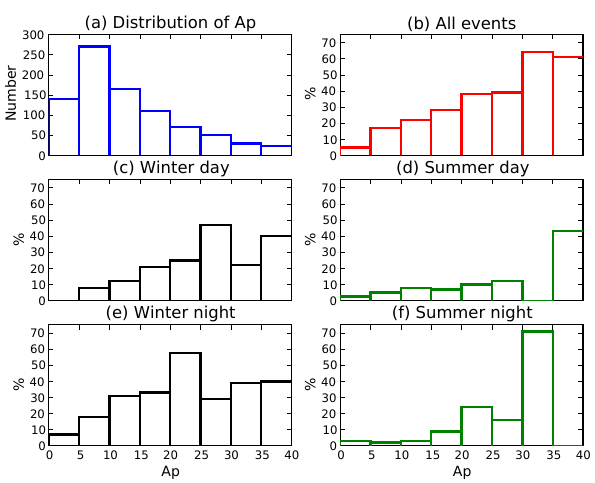
Fig. 4. Variation of event incidence with A p overall and within the defined daily and seasonal divisions. The histograms give the per- centage of days having at least one event. The statistical distribution of A p over the three years 1990–1992 is also shown.